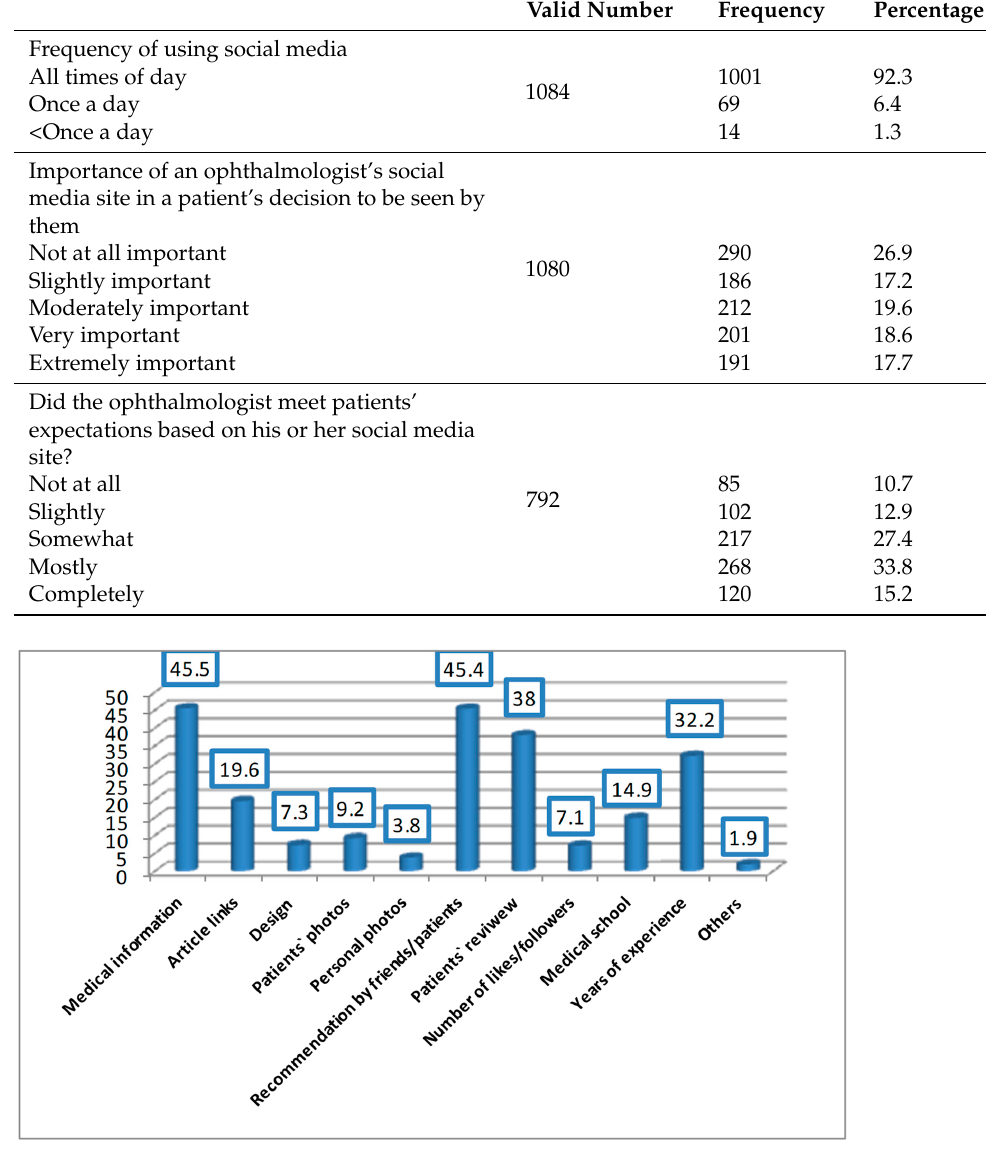
Figure 3. Important factors of an ophthalmologist’s social media site: Participants’ perspectives. Table 3. Reasons for visiting ophthalmologists among the participants ( n =